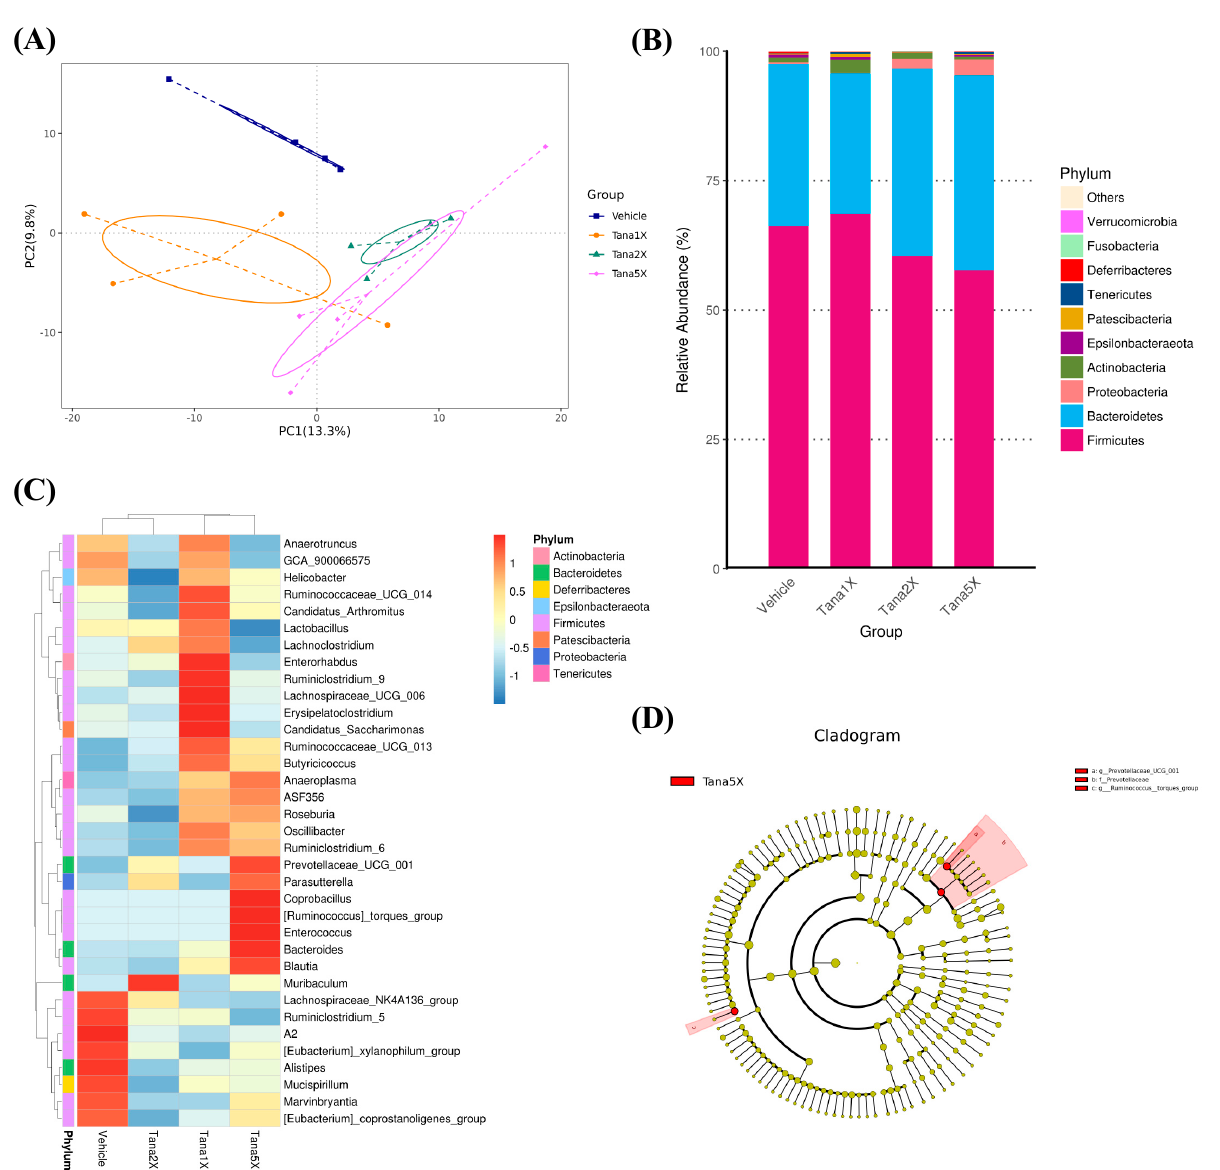
Figure 6. Effect of Tana supplementation: ( A ) effects of Tana supplementation on principal coordinate analysis (PCoA) of the gut microbiota composition in mice based on the Bray–Curtis distance measure of samples in the relative abundance profiles of an operational taxonomic unit; ( B ) effects of Tana supplementation on the phylum-level gut microbiota composition of mice. Only the top 10 phyla in average abundance are included; other phyla are classified as “Other”; ( C ) genus heatmap of gut microbiota; and ( D ) Tana-5× and vehicle group. Clade plots were generated from linear discriminant analysis effect size (LEfSe) analyses showing enrichment of the most differentially abundant taxa.